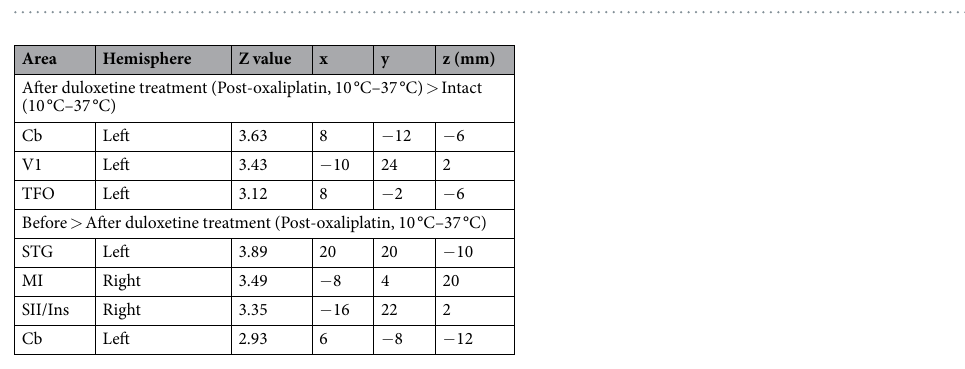
Table 2. Brain areas showing significant changes in activation after duloxetine treatment in oxaliplatin-treated macaques. Z -value of the peak voxels are indicated. The locations are indicated with the positions along the x (ipsi-contralateral), y (rostro-caudal) and z (dorso-ventral) axes of the Horsley-Clarke stereotaxic coordinates. Cb, cerebellum; Ins, Insular cortex; MI, primary motor cortex; SII, secondary somatosensory cortex; STG, superior temporal gyrus; TFO, area TFO of the parahippocampal cortex; V1, primary visual